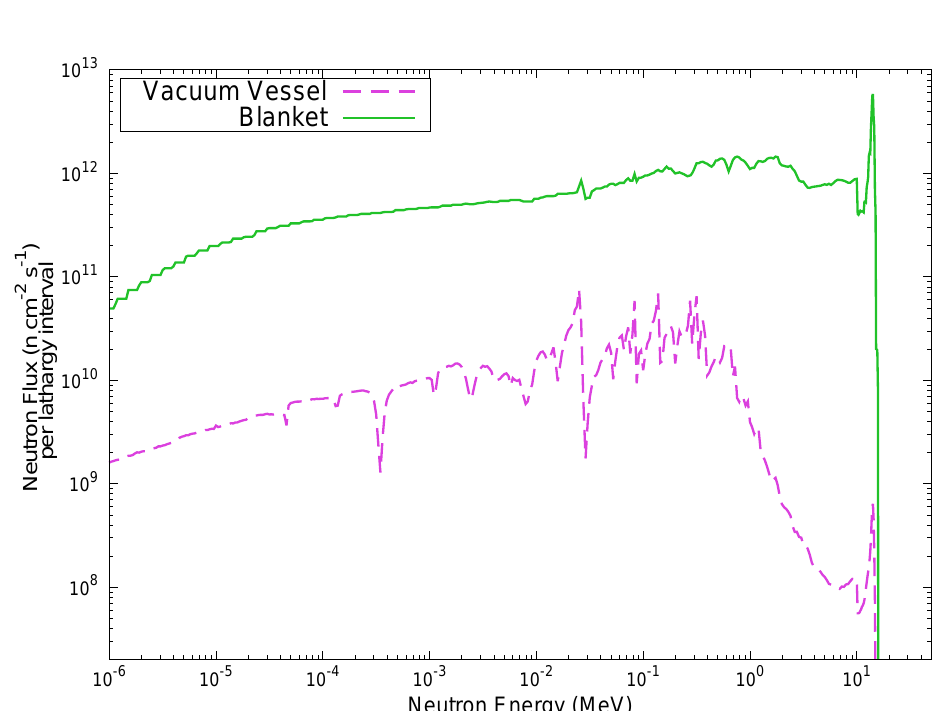
Figure 1: Neutron flux spectra used in the inventory simulations detailed in this work. The spectra were found using the Monte Carlo Transport code MCNP [19,20].